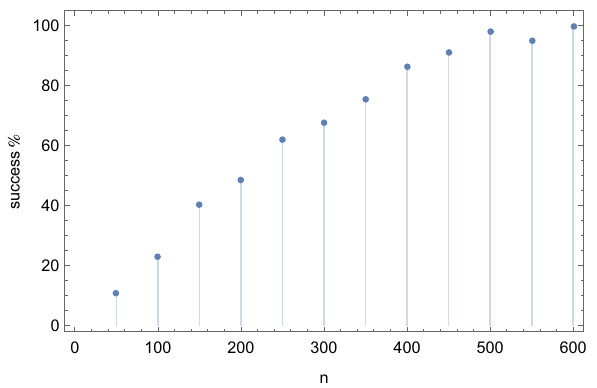
Fig. 9 Spectral method for finding block structure. Classification suc- cess percentile as a function of n using several repetitions (100) of experiments and 1000 classification instances for